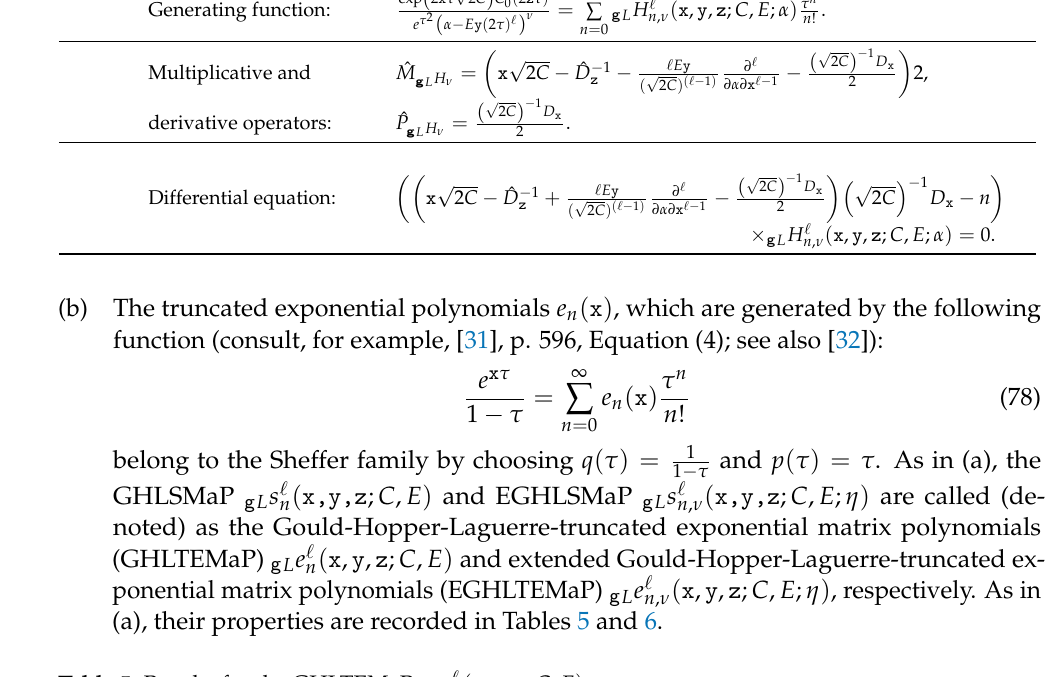
Table 5. Results for the GHLTEMaP g L e (cid:96) n ( x , y , z ; C , E ) . Results